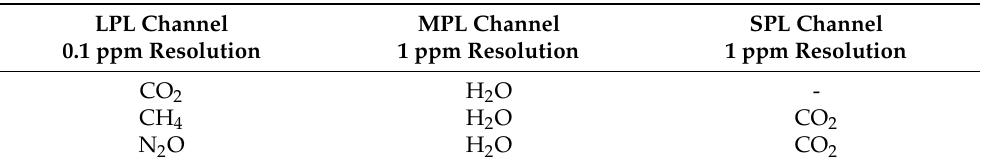
Table 1. List of the available gas-sensing configurations of the K96 sensor with respect to the different gas-sensing channels and resolutions.